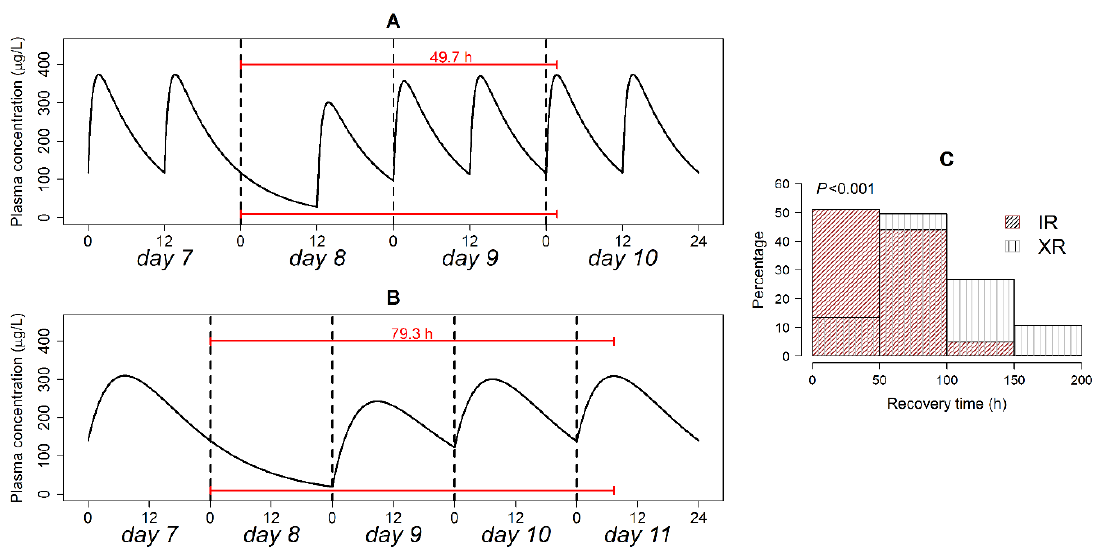
Figure 5. Recovery time in a typical patient following the omission of the IR ( A ) and XR ( B ) formulation doses; and relative frequency of recovery times in patients on both formulations ( C ). p -value of the Kolmogorov–Smirnov test is shown in panel ( C ).